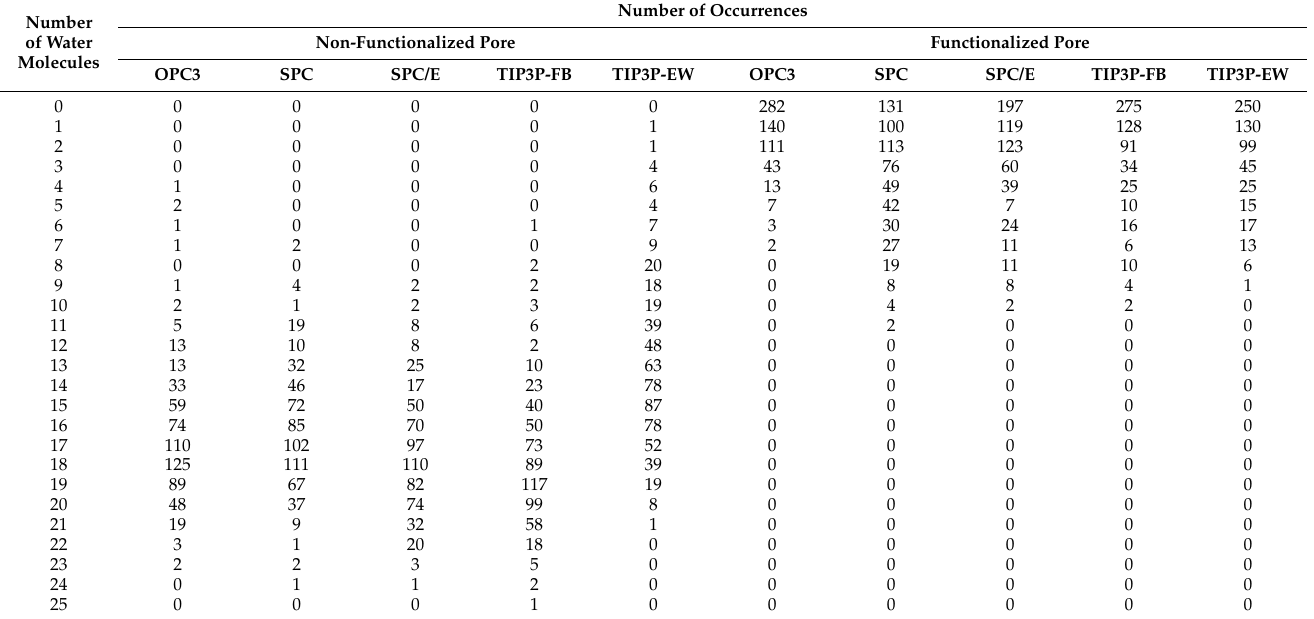
Figure 5. Free energy of occupancy fluctuations of water molecules inside ( a ) multilayered non- functionalized porous graphene and ( b ) multilayered functionalized porous graphene using different water models. Table 2. List of water molecules and number of occurrences inside the pore for the 6 ns